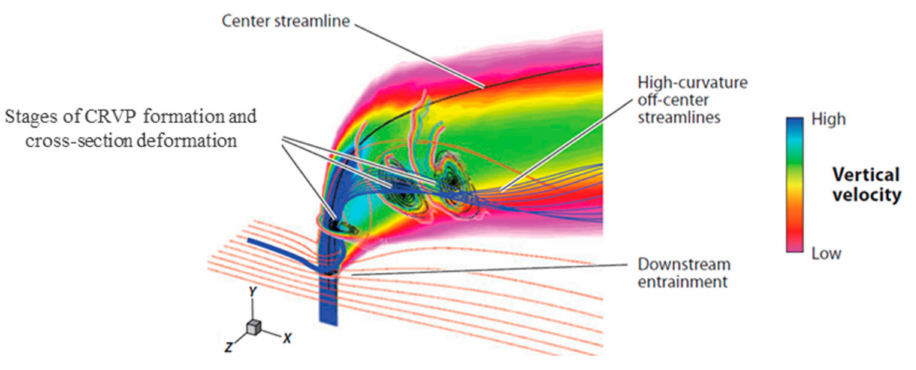
Figure 7. Contours of vertical velocity displayed on the symmetry plane